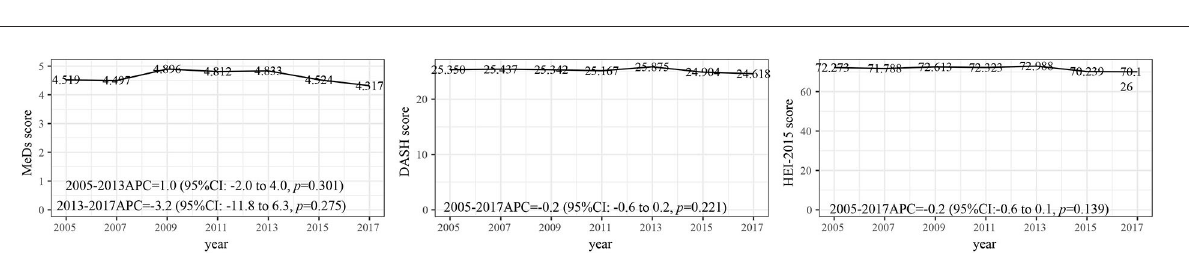
FIGURE3 Mean dietary scores between 2005 and 2017. MEDS, Mediterranean; DASH, Dietary Approaches to Stop Hypertension; HEI-2015, Healthy Eating Index 2015; APC, annual percentage changes; CI, confidence interval.